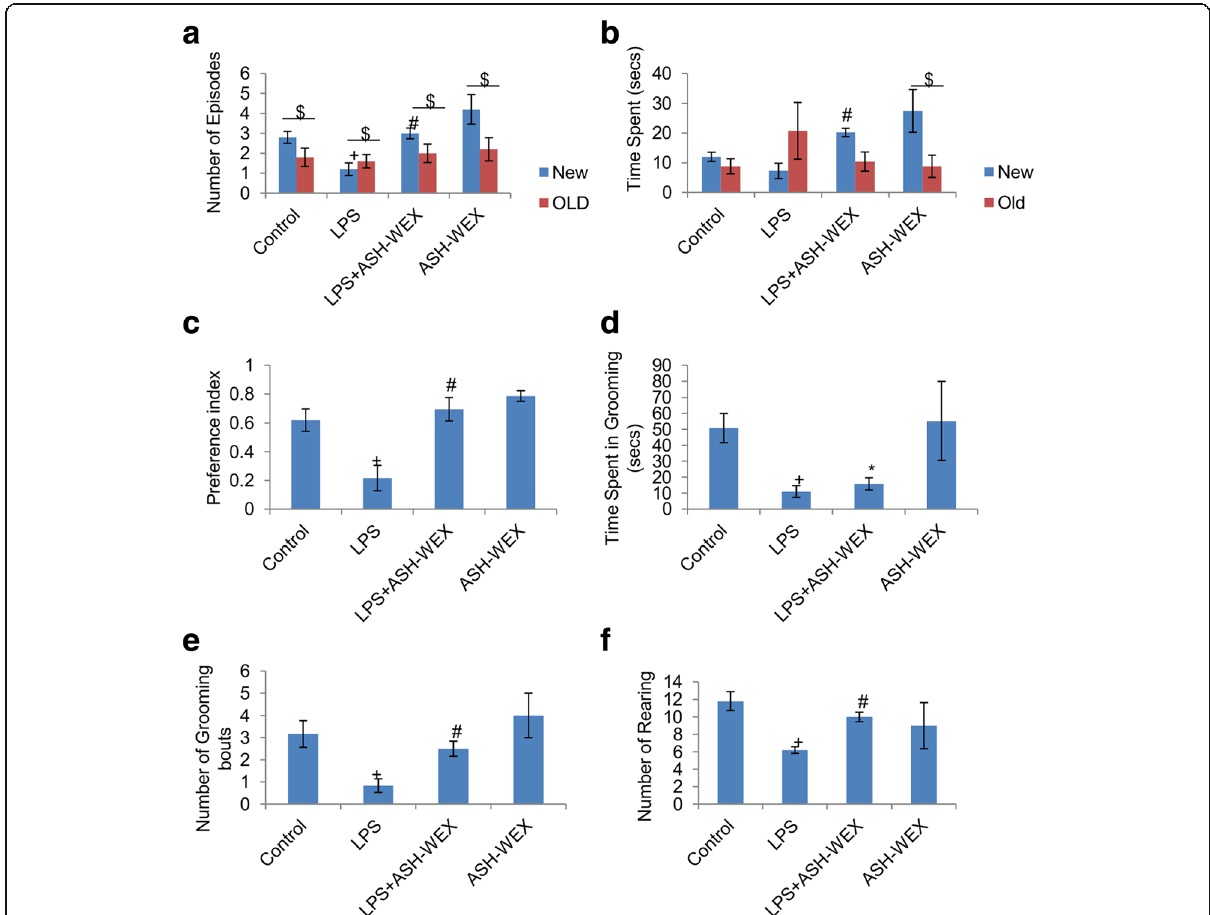
Fig. 2 ASH-WEX improves working memory and learning functions Performance of animals (n = 8/group) in Novel object recognition test was presented in panel a-f. ASH-WEX supplemented LPS (LPS + ASH-WEX)-treated rats exhibited more ( a ) number of episodes and ( b ) time spent in exploration of new object than the old one as compared to LPS-treated rats. ( c ) Histogram presenting significantly higher preference index of LPS + ASH-WEX-treated animals for new object over the old one indicates their intact recognition memory. ( d , e , f ) Histograms depicting the number and duration of the grooming bouts and number of rearings among the different treated groups. Values are expressed as mean ± SEM. * p ≤ 0.05 control versus ASH-WEX alone and LPS + ASH-WEX groups. + p ≤ 0.05 control versus LPS alone group. # p ≤ 0.05 LPS alone versus LPS + ASH-WEX group. $ represents statistically significant difference within groups (New vs. Old in each group) (one-way ANOVA with Holm-Sidak post hoc test, two-way ANOVA in a , b